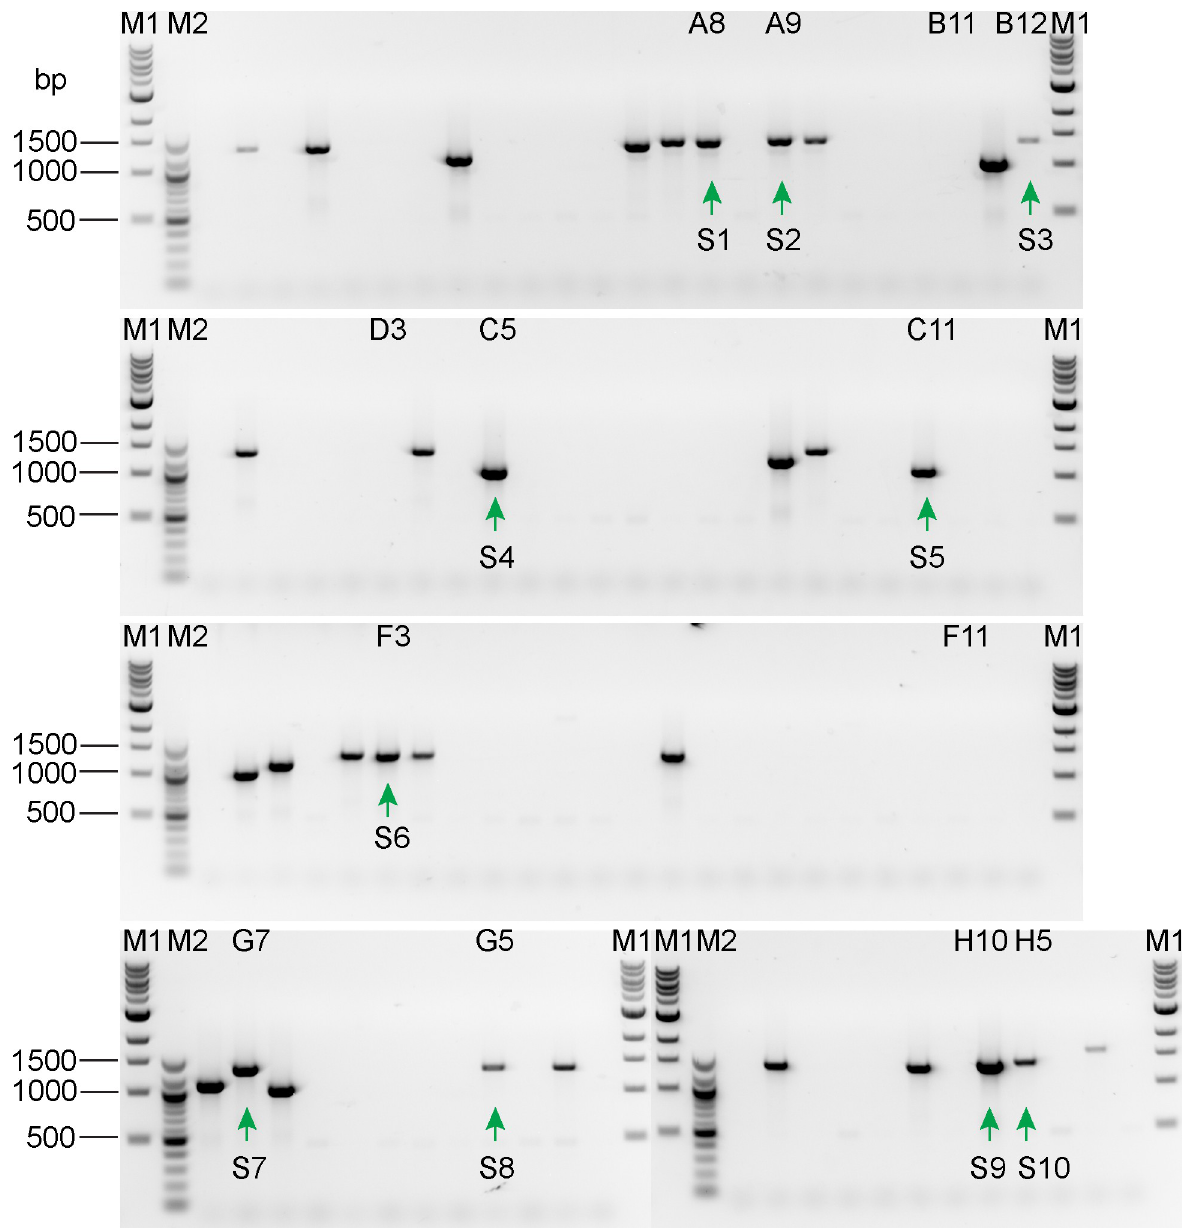
Fig 9. PCR screening of transformants for insertion of the 5’ end of the NAP1L1 mNeonGreen-3xFLAG donor DNA at the RNP1 cut site. Crude DNA preparations from the same 96 transformants and in the same order as those analyzed in Fig 8 were used as templates for PCR amplification with primer pairs P3/P4 as illustrated in Fig 4. Because P4 is complementary to sequence in the antibiotic-resistance gene, no PCR product is expected for the wild-type gene. The expected product size for correct editing at the RNP1 target site is 542 bp. However, the PCR products are around 1–1.5 kb. A product of 1350 bp is expected if the RNP1 target site was not cut and the donor DNA inserted cleanly at the RNP2 cut site. To explore this possibility, we sequenced product (here marked S1-S10 below the bands) from 10 clones (labeled at the top of the lanes as in Fig 8) that had yielded product of the correct size with primer pair P1/P2. The results (S4 Appendix) confirmed that the RNP1 target site was not cut and the donor DNA had inserted into the RNP2 cut site, but with modification of its 5’ end. M1: NEB 1 kb DNA ladder (catalog number NO552). M2: NEB 100 bp DNA ladder (catalog number NO551). The band sizes from top to bottom for M1 are 10, 8, 6, 5, 4, 3, 2, 1.5, 1, and 0.5 kb. The band sizes from top to bottom for M2 are 1517, 1200, 1000, 900, 800, 700, 600, 500/517, 400, 300, 200, and 100 bp.